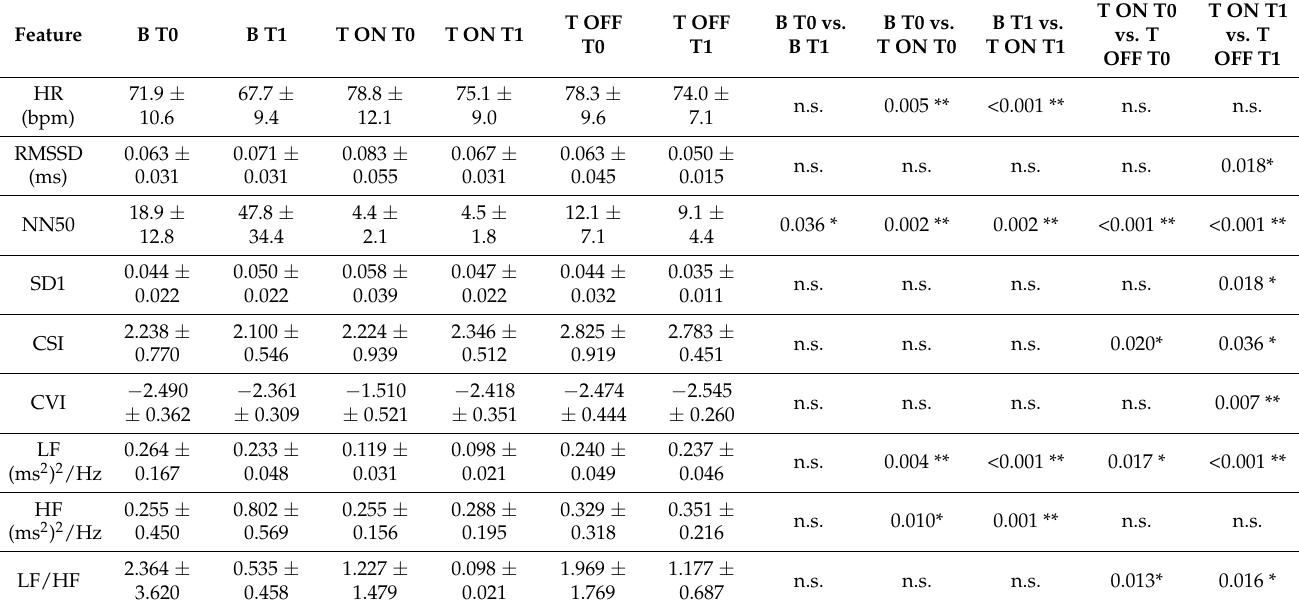
Table 3. Main results concerning the ECG features throughout the protocol phases (B: baseline, T OFF: task inter-stimulus, T ON: task with olfactory stimulation; *: p < 0.05; **: p < 0.01; n.s.: not significant). Feature